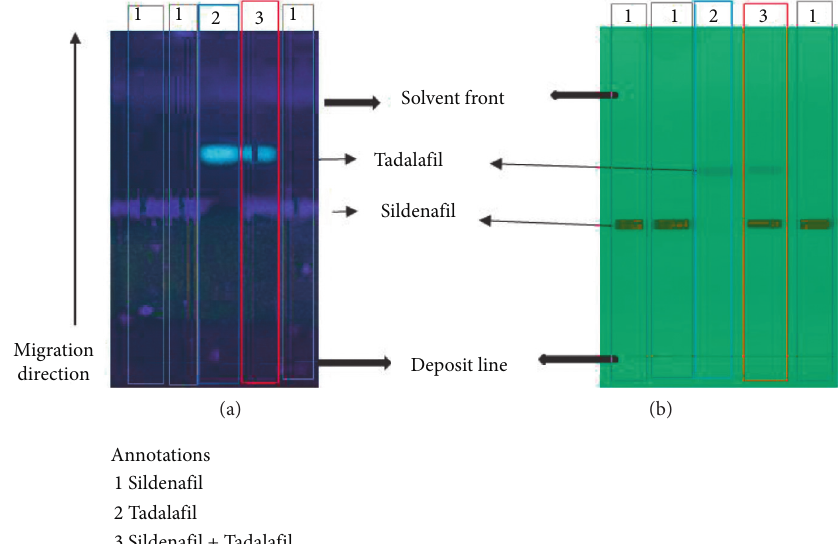
Figure 2: (a) Chromatographic plate revealed under 366nm light. (b) Chromatographic plate revealed under 254nm light.